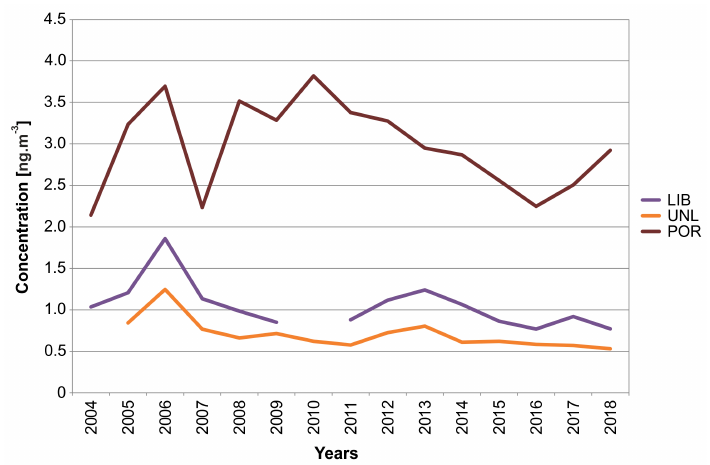
Figure 12. Trends in ambient annual mean BaP concentrations at selected sites (see Table 1, Figure 2), 2004–2018, based on CHMI data.